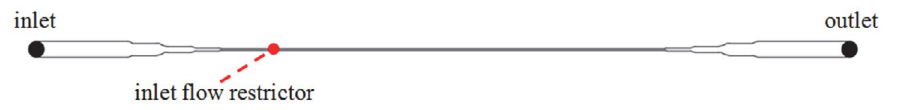
Figure 2. Design of a single microchannel with an inlet flow restrictor.